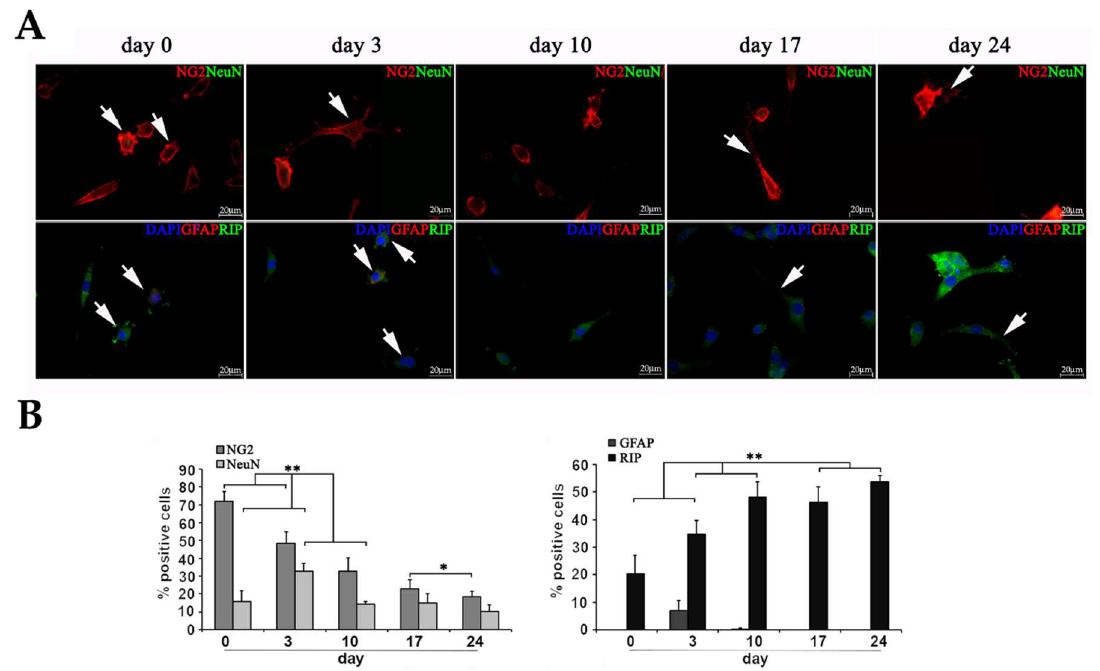
Figure 5. Characterization of diff-Ns by immunofluorescence. ( A ) Immunofluorescence analysis of GFAP (red), RIP (green), NG2 (red), NeuN (green) and DAPI nuclei (blue) in diff-Ns differentiated as described in Figure 3A. ( B ) The percentage of positive cells was quantified by counting the number of GFAP-, RIP-, NG2- and NeuN-positive cells as a proportion of blue DAPI positive nuclei. Cells expressing oligodendroglial markers at the days 0 and 3 of differentiation branch short processes from a round and small body (arrows) and extend slim longer branches from a flat and larger cell body at the late days of differentiation (arrows). ** p < 0.01, * p < 0.05 day 3, 10, 17 or 24 versus the previous time of differentiation. Scale bar = 20 µ m. Magnification 63 ×